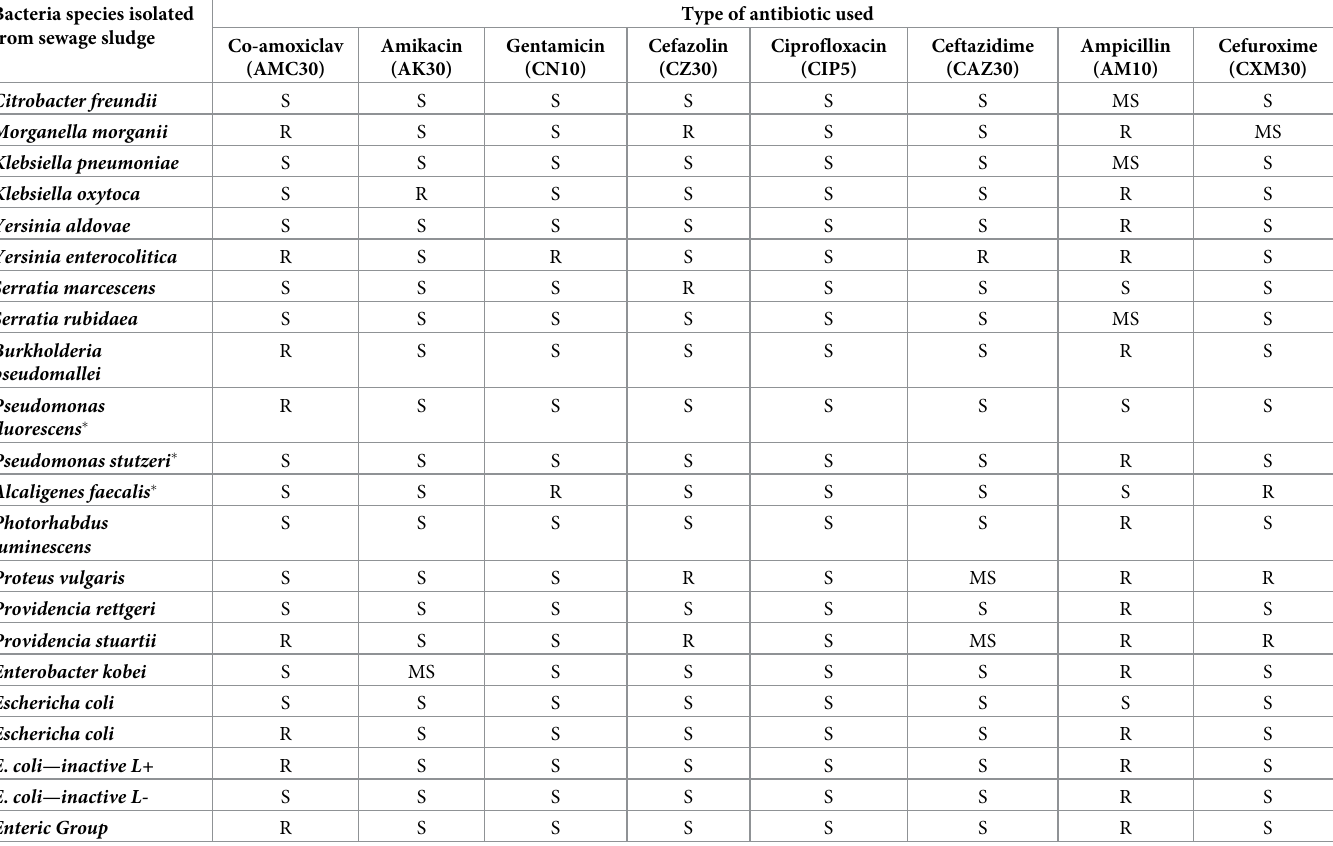
Table 5. Results of antibiograms for individual bacteria from the Enterobacteriaceae family and saprophytic bacteria isolated from sewage sludge. Bacteria species isolated from sewage